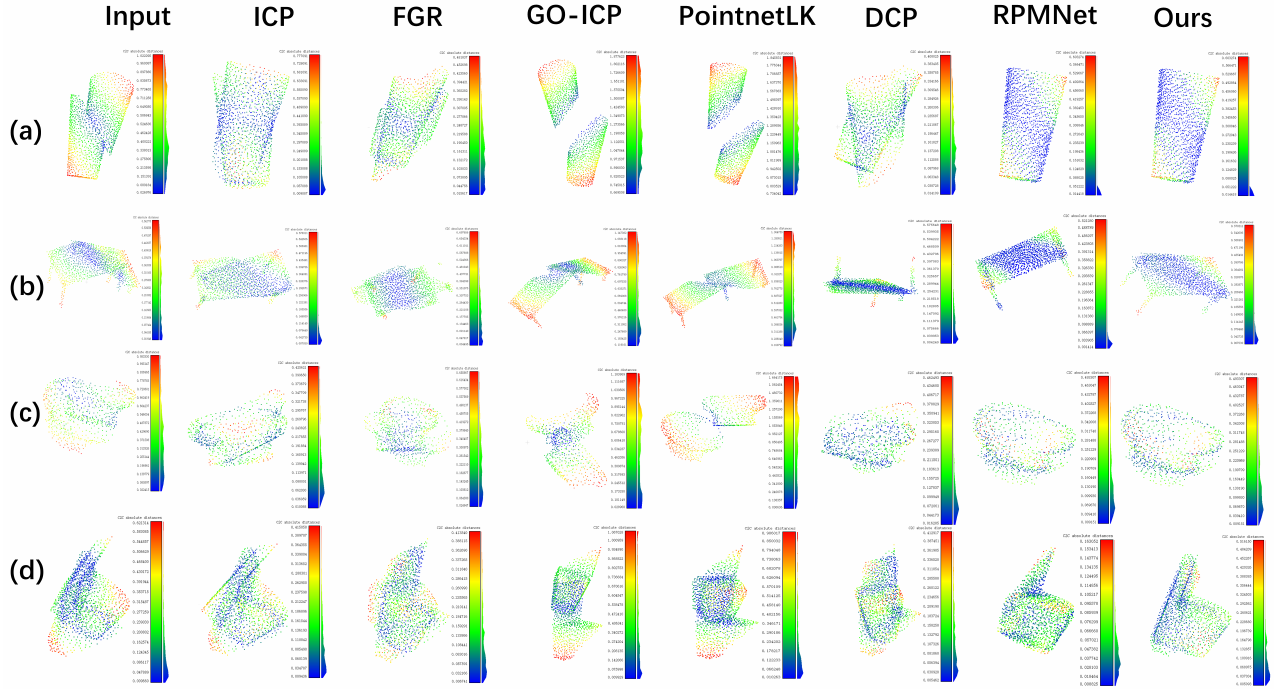
Figure 3. Registration examples on ( a ) unseen categories, ( b ) noisy data, ( c ) sparse data, and ( d ) data with rotation of 30–40°. The histograms on the right show the distance between the points. The closer to the blue, the smaller the distance between the